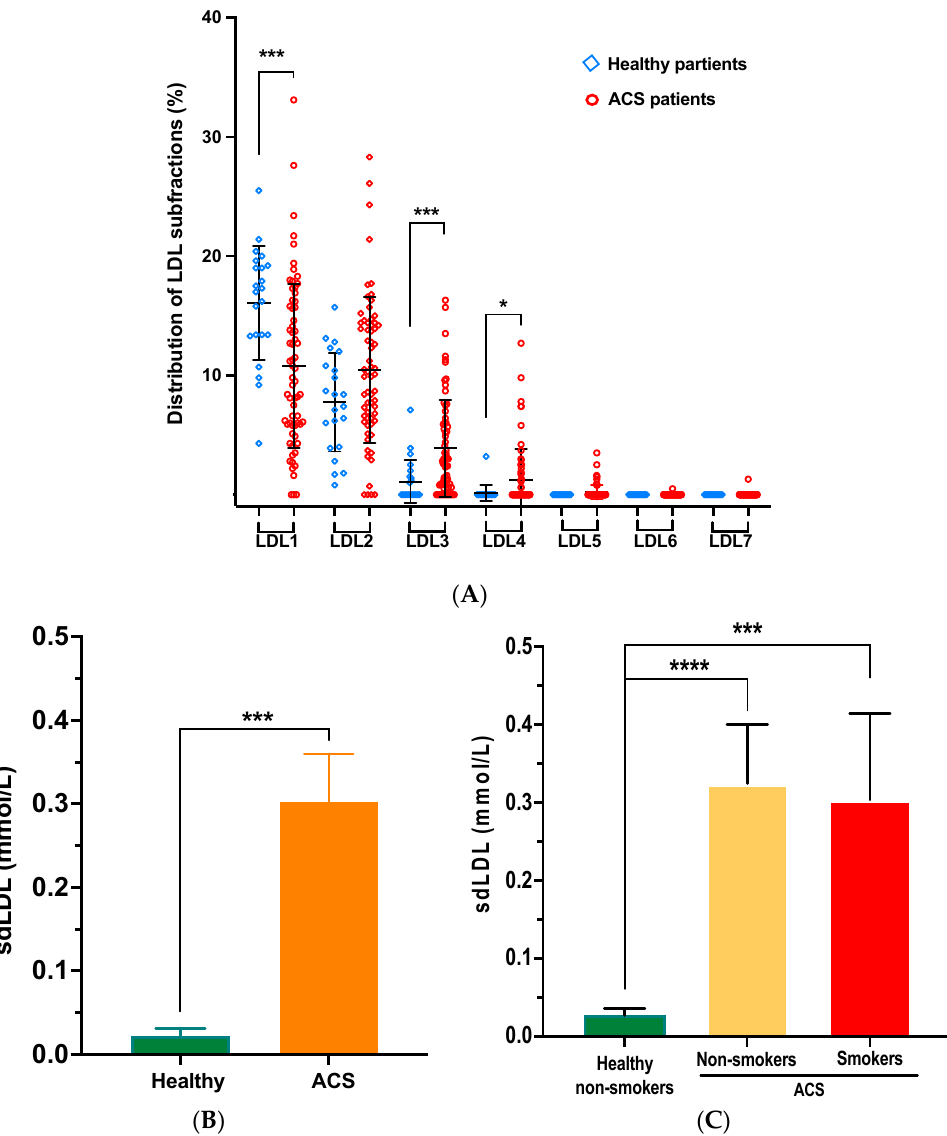
Figure 2. ( A ) Lipoprotein subclass distribution of LDL from ACS patients compared to healthy con- trol subjects. ( B ) Measurement of sdLDL-forming LDL obtained from ACS patients compared to healthy control subjects. ( C ) Measurement of sdLDL-forming LDL obtained from non-smoker and smoker ACS patients compared to healthy (non-smoker) control subjects. LDL subclass distribution analysis and sdLDL quantification were determined using the Quantimetrix ® Lipoprint ® LDL Sys- tem.**** p < 0.0001 *** p < 0.0003 and * p < 0.01.